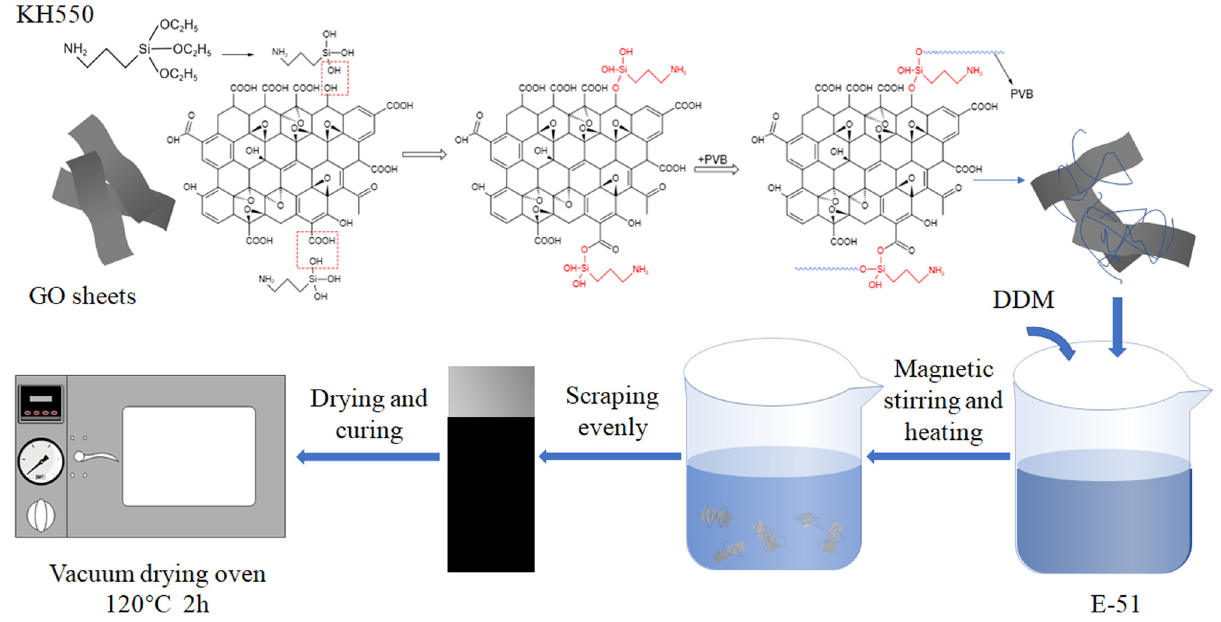
Figure 1: Preparation diagram of the GO/PVB/EP nanocomposite